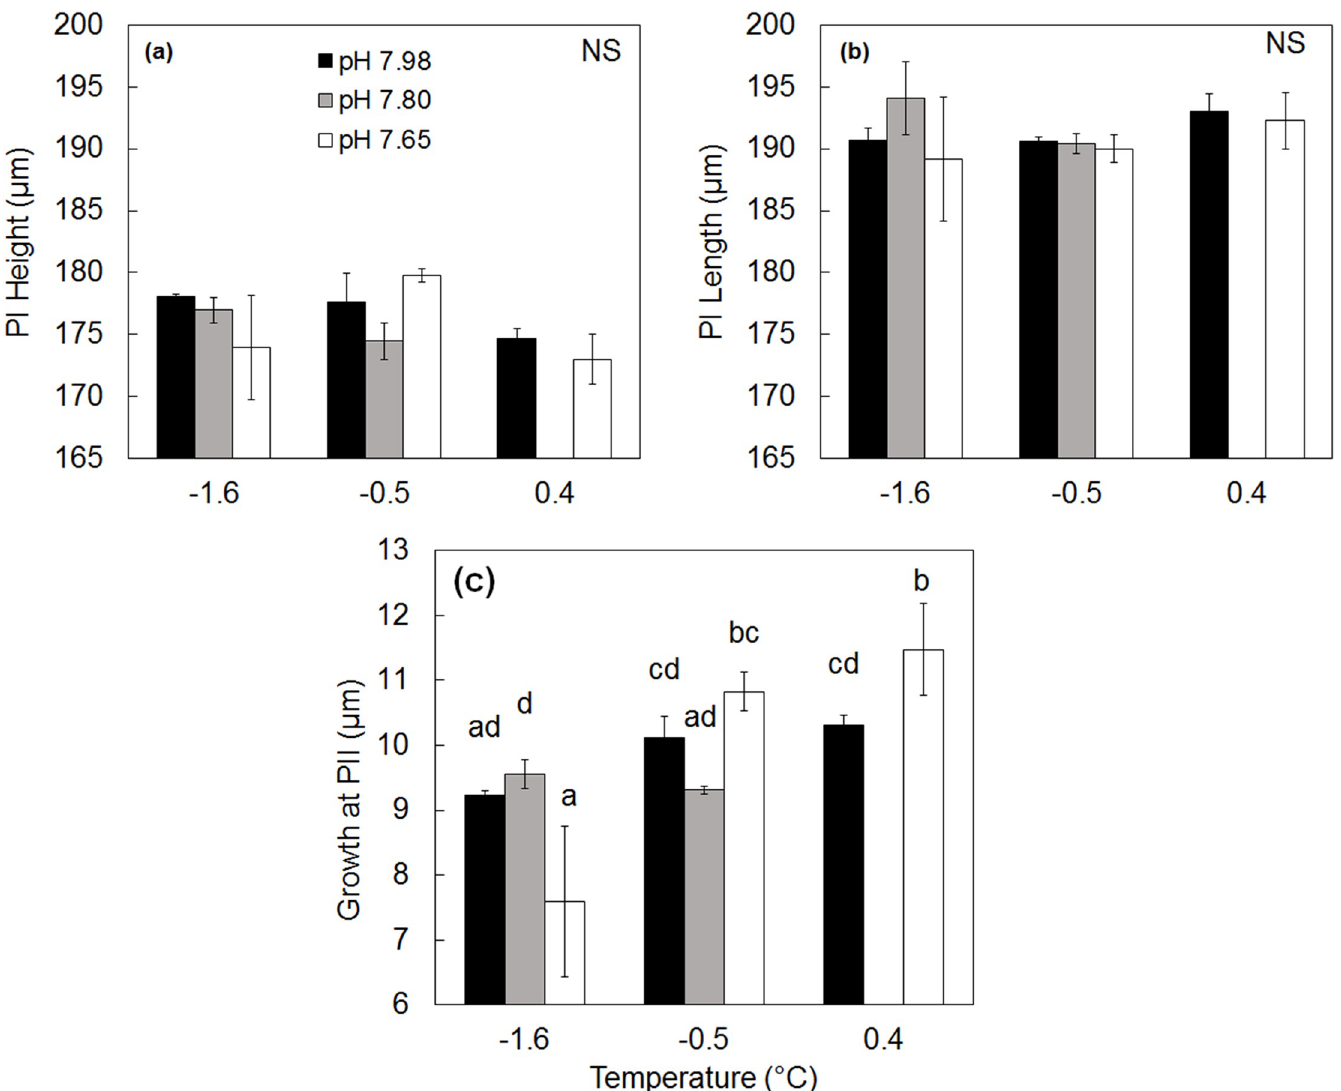
Fig 4. Effects of reduced pH and elevated temperatures on shell sizes. a) Shell heightand b) shell length on prodissoconch I (PI) and c) on growth of prodissoconch II. Letters indicatesignificanceas in Fig 2. The temperature/pH combination of 0.4˚C/7.80 was not used. NS = no significantdifferences betweentreatments, n = 3. Error bars are standard